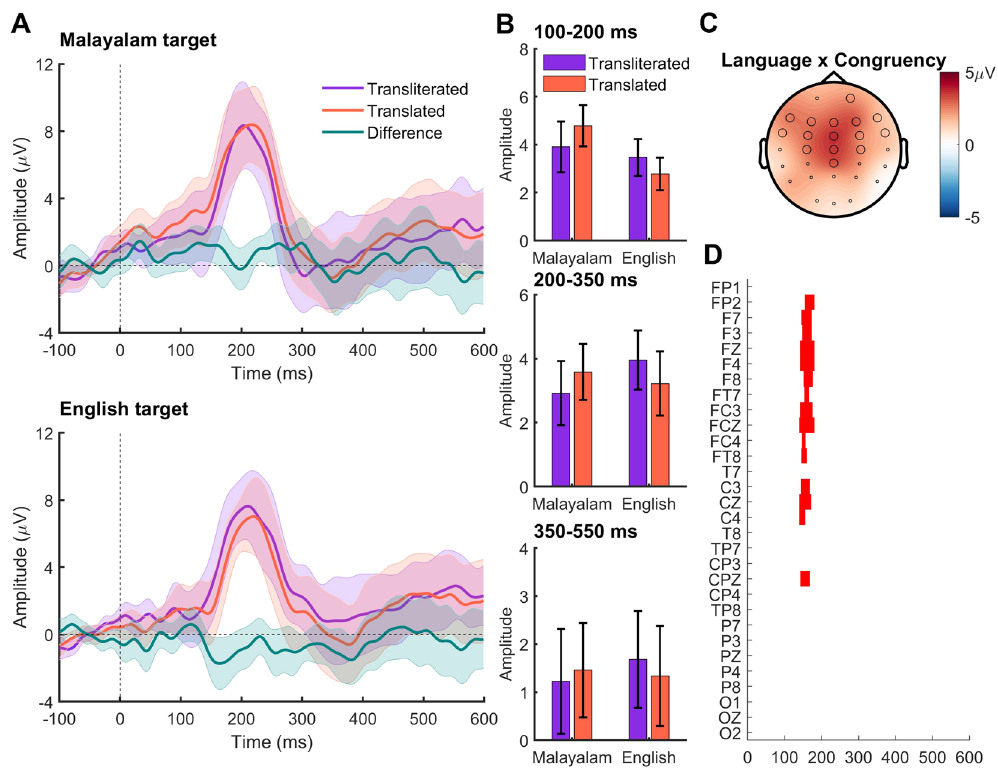
Figure 2. ( A ) ERPs across the conditions. The solid lines represent grand averaged ERPs and the shading encompasses 95% confidence intervals. ( B ) The mean amplitude calculated from 9 electrodes in the central scalp location across different time windows. The error bars represent standard error of mean. ( C ) The topography of the language x congruency effect at 155 ms. The highlighted electrodes belong to a statistically significant cluster ( D ) p values masked for significance ( p < .05) for the language x congruency interaction effect on the basis of the cluster-based permutation test. The x axis represents the time (in milliseconds and y axis represents the 30 recording